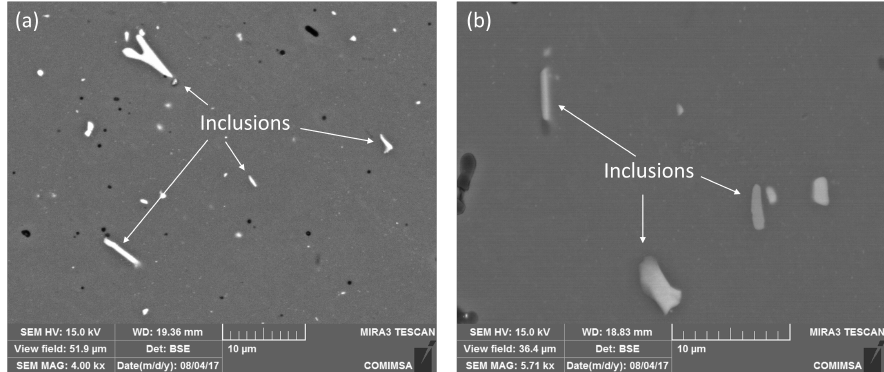
Figure 2. Microstructure of ( a ) AA6061–T6 (as-received) alloy, and ( b ) AA6061–T4 heat-treated alloy.